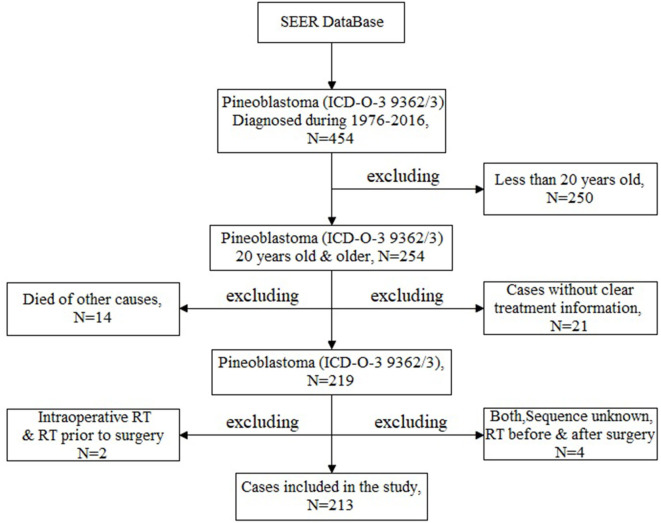
The flow chart of patient enrollment.